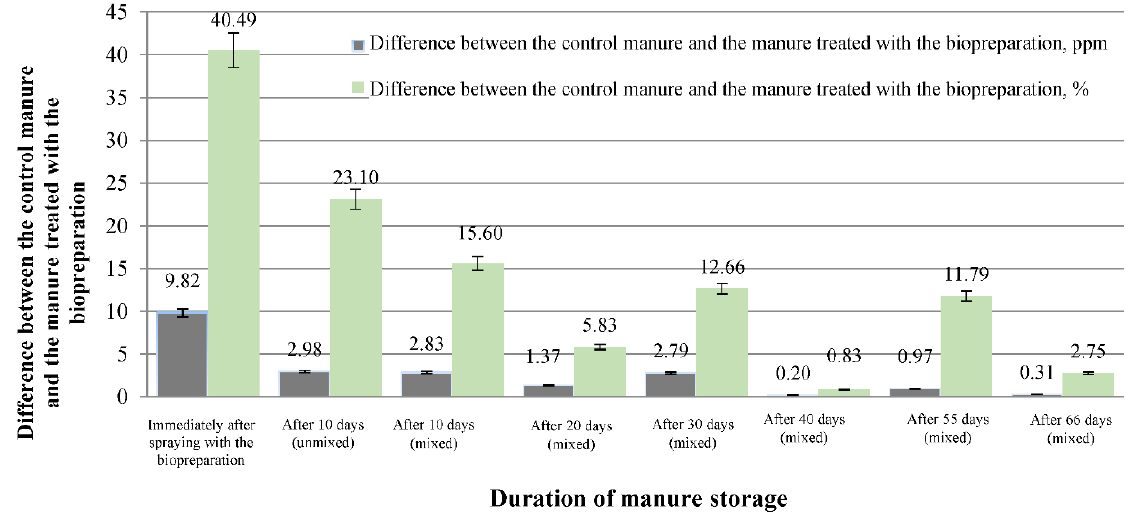
Figure 6. Change in ammonia concentration in the wind tunnel with the addition of the manure treated with the biopreparation and the control manure without additives (66 days after the addition of the biopreparation).